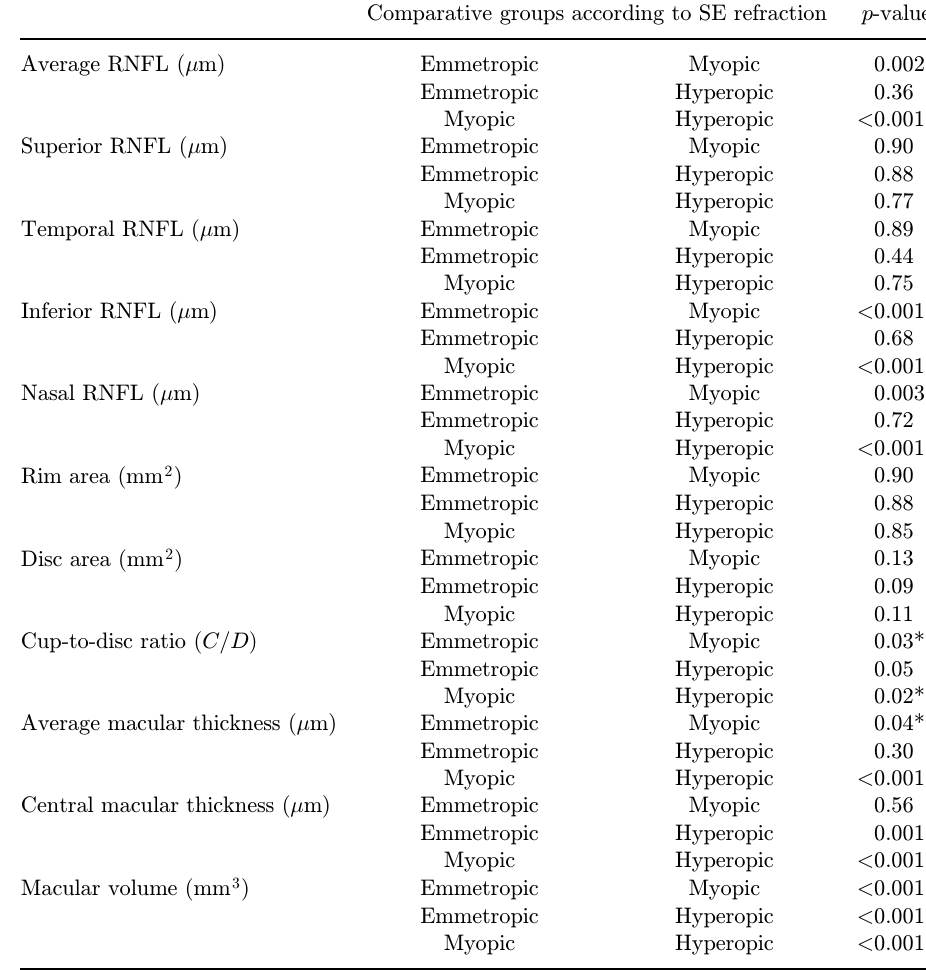
Table 1b. Post hoc analysis to determine pairwise di®erences among groups classi¯ed according to SE refraction (Bonferroni post hoc analysis). Comparative groups according to SE